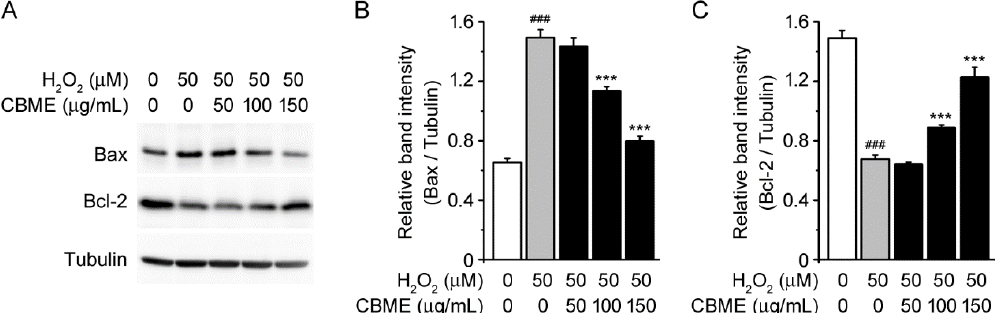
Figure 3. Effects of Chrysanthemum boreale Makino extract (CBME) on Bax and Bcl-2 expression in SH-SY5Y cells exposed to hydrogen peroxide. ( A ) Western blot bands corresponding to Bax and Bcl-2 in SH-SY5Y cells which were pre-treated with the indicated concentrations of CBME for 3 h and then exposed to H 2 O 2 for 24 h. Tubulin was used as the loading control. ( B ) Relative band intensity of Bax were quantified using densitometric analysis and then normalized to tubulin. ( C ) Relative band intensity of Bcl-2 was quantified using densitometric analysis and then normalized to that of tubulin. Values in the bar graphs are the mean ± SEM of at least three independent experiments. *** p < 0.005, significantly different from the H 2 O 2 group. ### p < 0.005, significantly different from the control group.